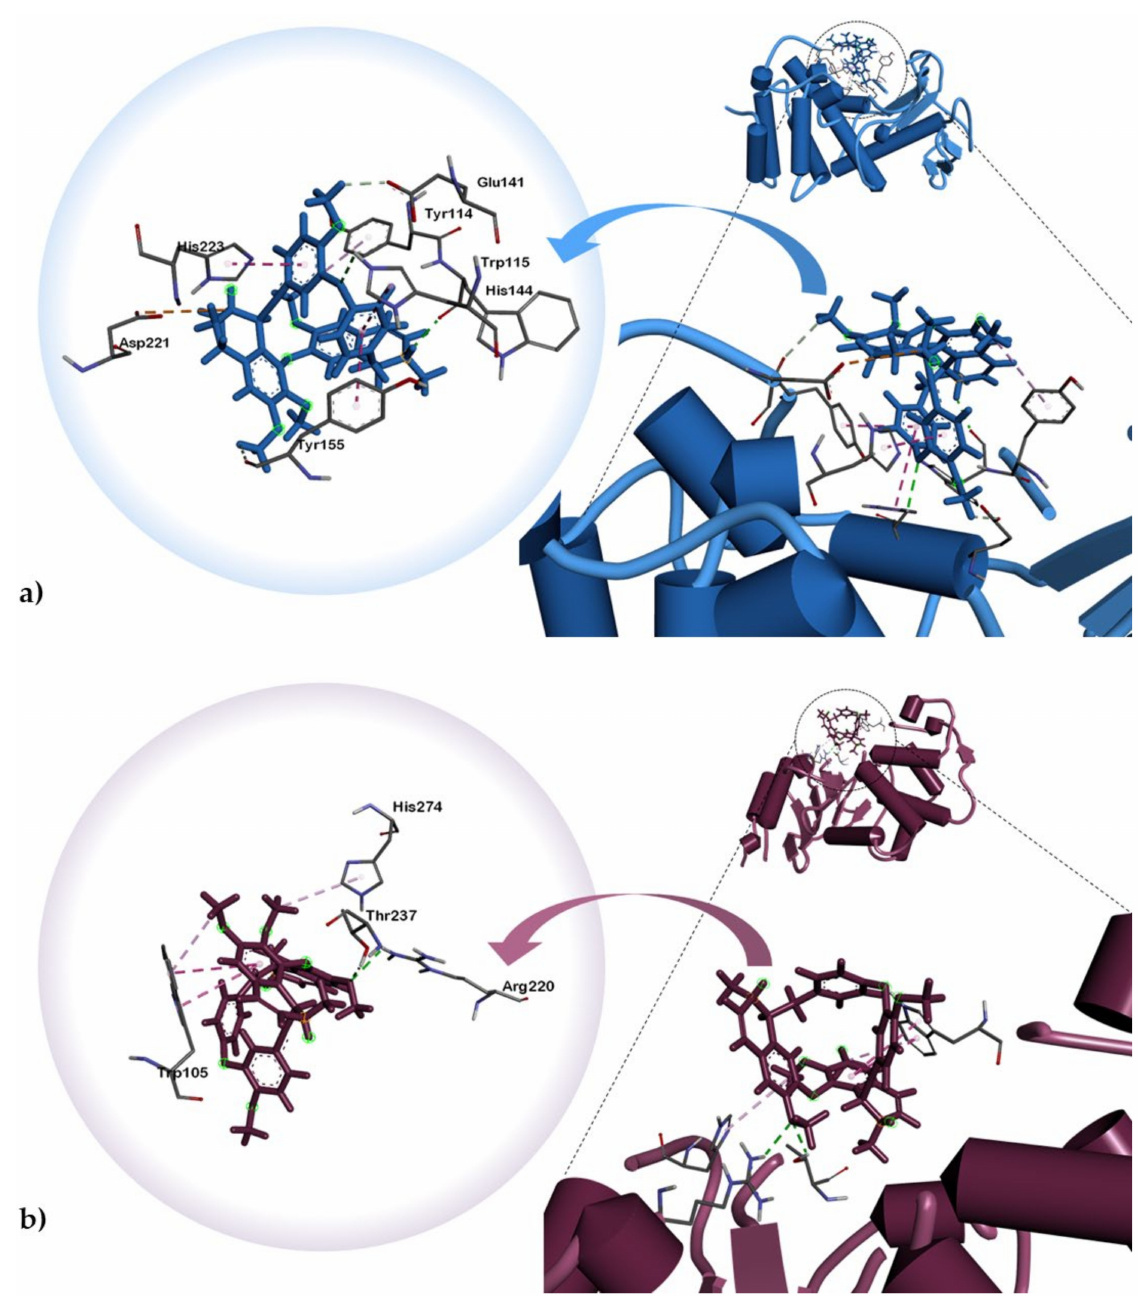
Figure 2. Dock poses of alkaloid 1 against ( a ) P. aeruginosa elastase (PDB ID: 1U4G) and ( b ) K. pneumoniae KPC-2 carbapene- mase (PDB ID: